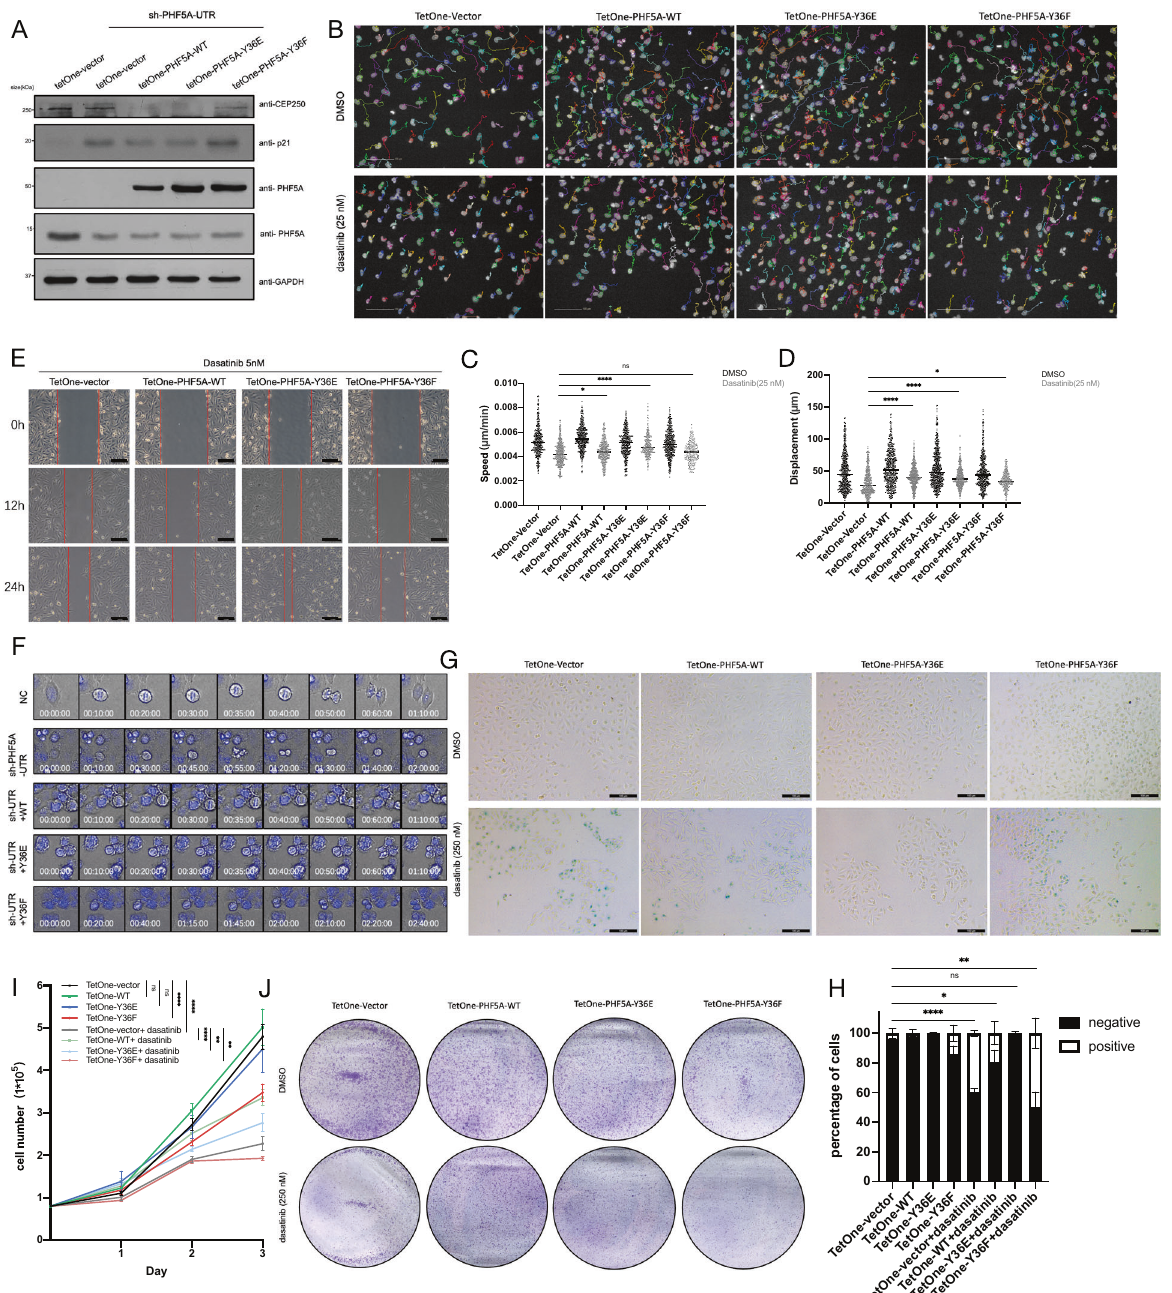
Fig. 7 pY36-PHF5A promotes medulloblastoma migration through centrosome separation and microtubule remodeling. A Immunoblotting analysis of CEP250 in PHF5A-WT, Y36E, or Y36F-DAOY-rescued cells. B Cell migration assays were performed in TetOne- DAOY cells (WT, Y36E or Y36F) treated with or without dasatinib (25 nM). Images were captured every 5 min. Scale bars: 100 μ m. C , D Cell migration speed ( C ) and displacement ( D ) were measured with cell migration assay (Harmony software). E Wound-healing assays were performed in TetOne-DAOY cells (WT, Y36E or Y36F) treated with dasatinib (5 nM). Images were captured at times 0, 12, and 24 h. Scale bars: 100 μ m. F Cell mitotic images were captured in PHF5A-WT, Y36E, or Y36F-shHela-rescued cells after being released from thymidine synchronization. Images were captured every 5 min. G , H SA- β -gal staining was performed in TetOne-DAOY cells (WT, Y36E or Y36F) treated with or without dasatinib (250 nM) ( G ). The percentage of positive staining cells were calculated ( H ). I DAOY cells were seeded into six-well plates at the same number with or without the treatment of dasatinib (250 nM). Cell numbers were counted every day ( n = 5). Scale bars: 100 μ m. J Colony formation assay was performed in TetOne-DAOY cells (WT, Y36E or Y36F) treated with or without dasatinib (250 nM). dasatinib also decreased the ratio of centrosome separation in Fig. S6B). Cells rescued by PHF5A-WT and PHF5A-Y36E increased interphase Daoy cells (Fig. S6E, F). Additionally, we observed the the ratio of centrosome separation while cells rescued by PHF5A- loosened microtubule arrangement in PHF5A-Y36F rescued cells Y36F decreased the ratio of centrosome separation in interphase (Fig. S6G) or treatment with low-dose of dasatinib (Fig. S6H). The Daoy cells (Fig. S6C, D). Downregulation of pY36-PHF5A by migration assay showed that low-dose of dasatinib inhibited the treating cells with TrkA inhibitor taletrectinib or ABL1 inhibitor Cell Death and Disease (2023)